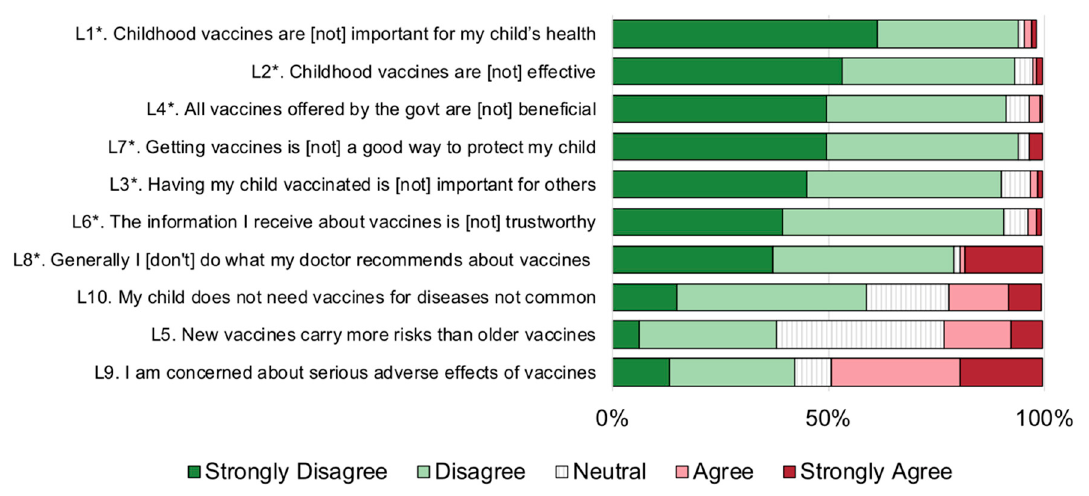
Figure 1. Overall patterns of vaccine hesitancy across the five surveyed Low- and Middle-Income Countries (LMICs), presented by question. Note, questions with a * were reverse coded so that the scale was in the same direction for all questions, with higher scores (1–5, 5 representing ‘Strongly Agree’, corresponding to higher vaccine hesitancy scores).